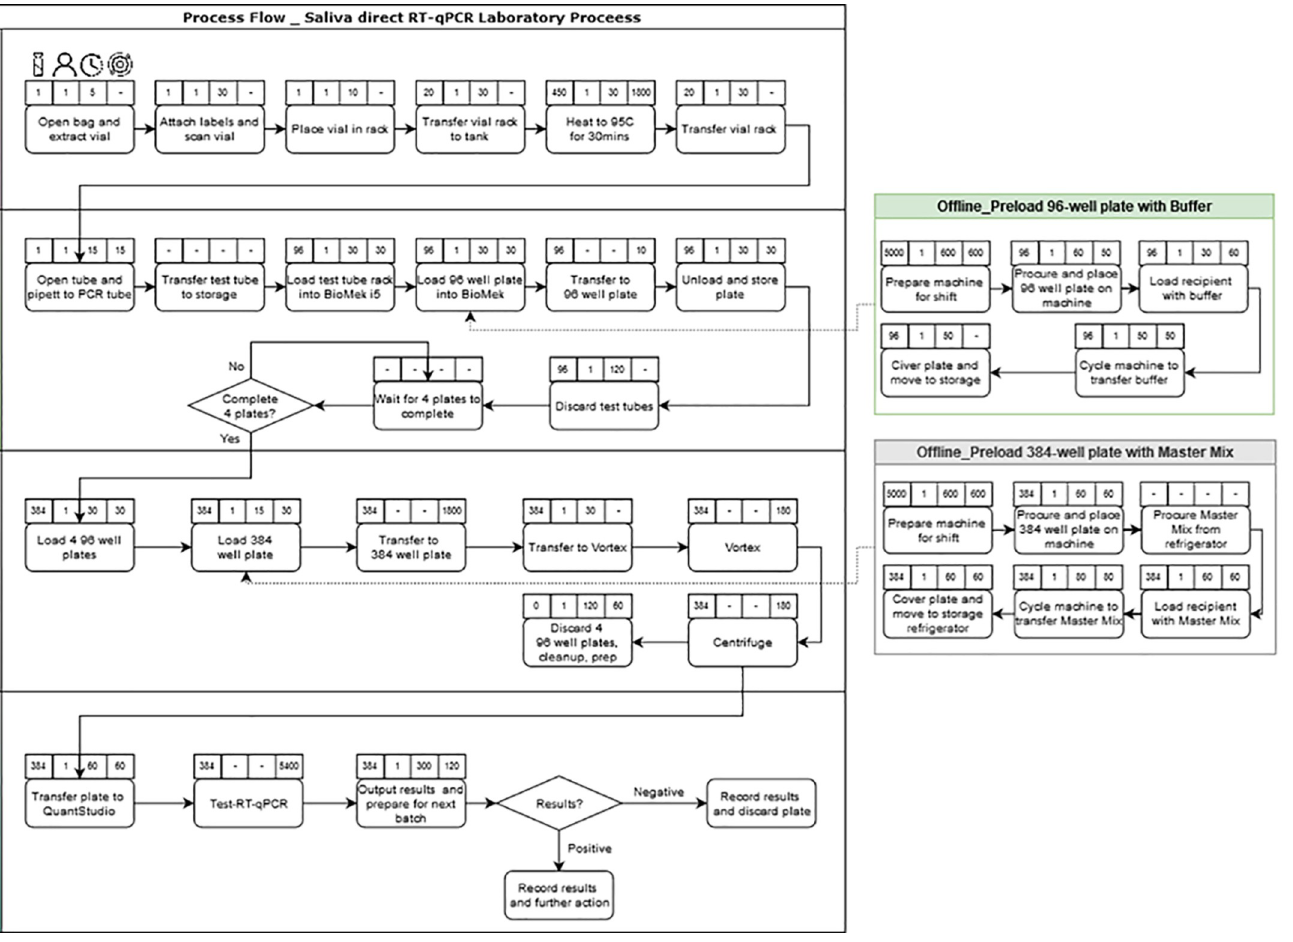
Fig 3. Workflow model of the COVID-19 testing process, used for developing the DES model.